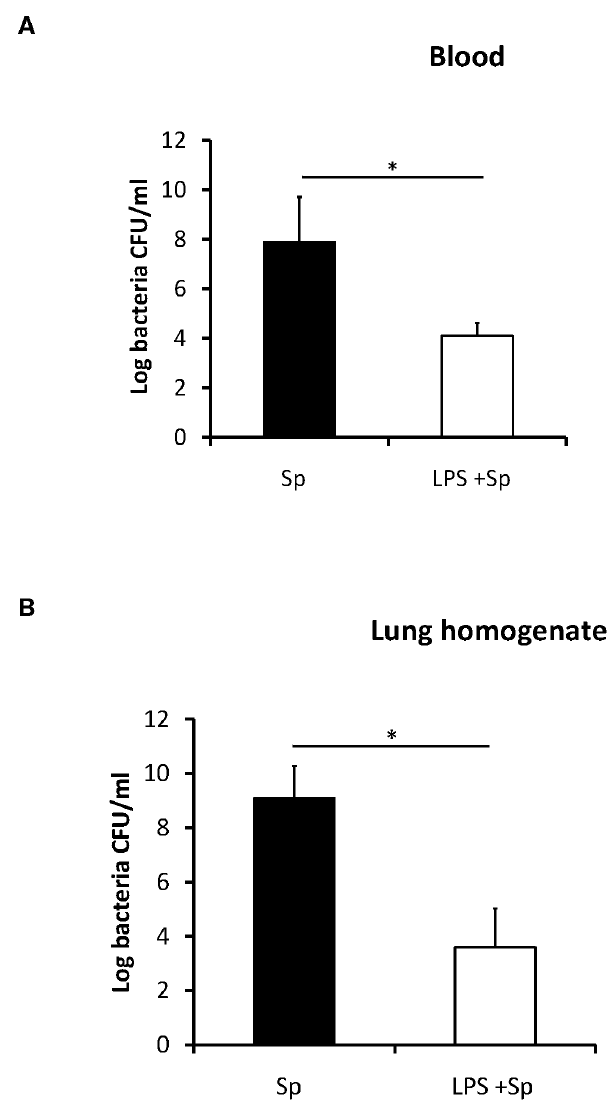
Figure 3. Bacterial clearance in (A) blood (N=5 – 8 per group), and (B) lung homogenates (N=3 per group) after S.pneumoniae challenge in LPS pretreated and PBS treated control mice. The results are expressed as the mean and standard deviations (SDs) are indicated by error bars, *t-test, p , 0.05.